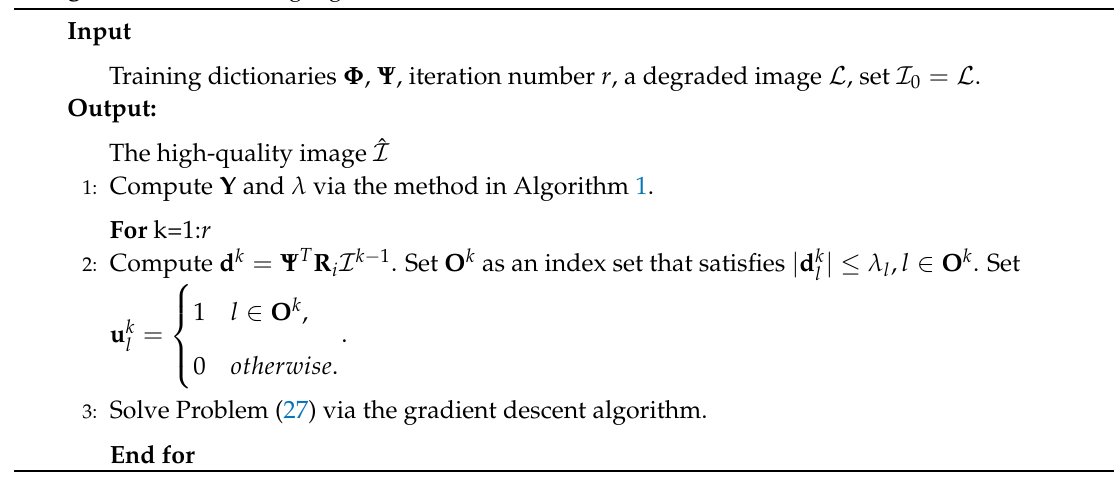
Algorithm 3: Denoising